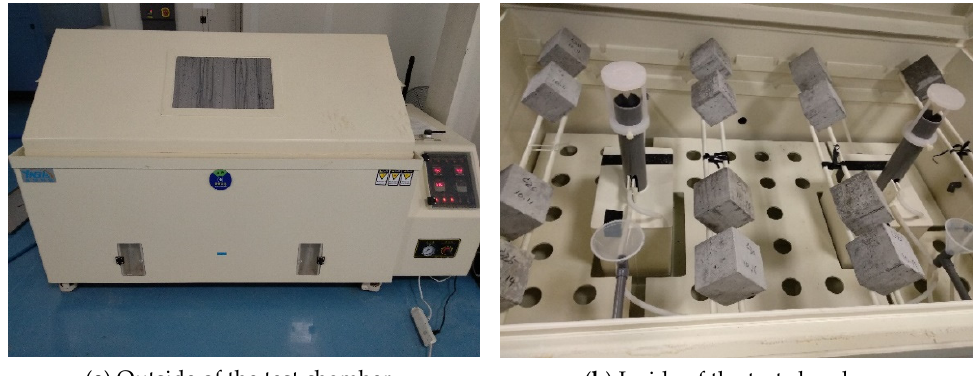
Figure 1. Salt spray corrosion test chamber.